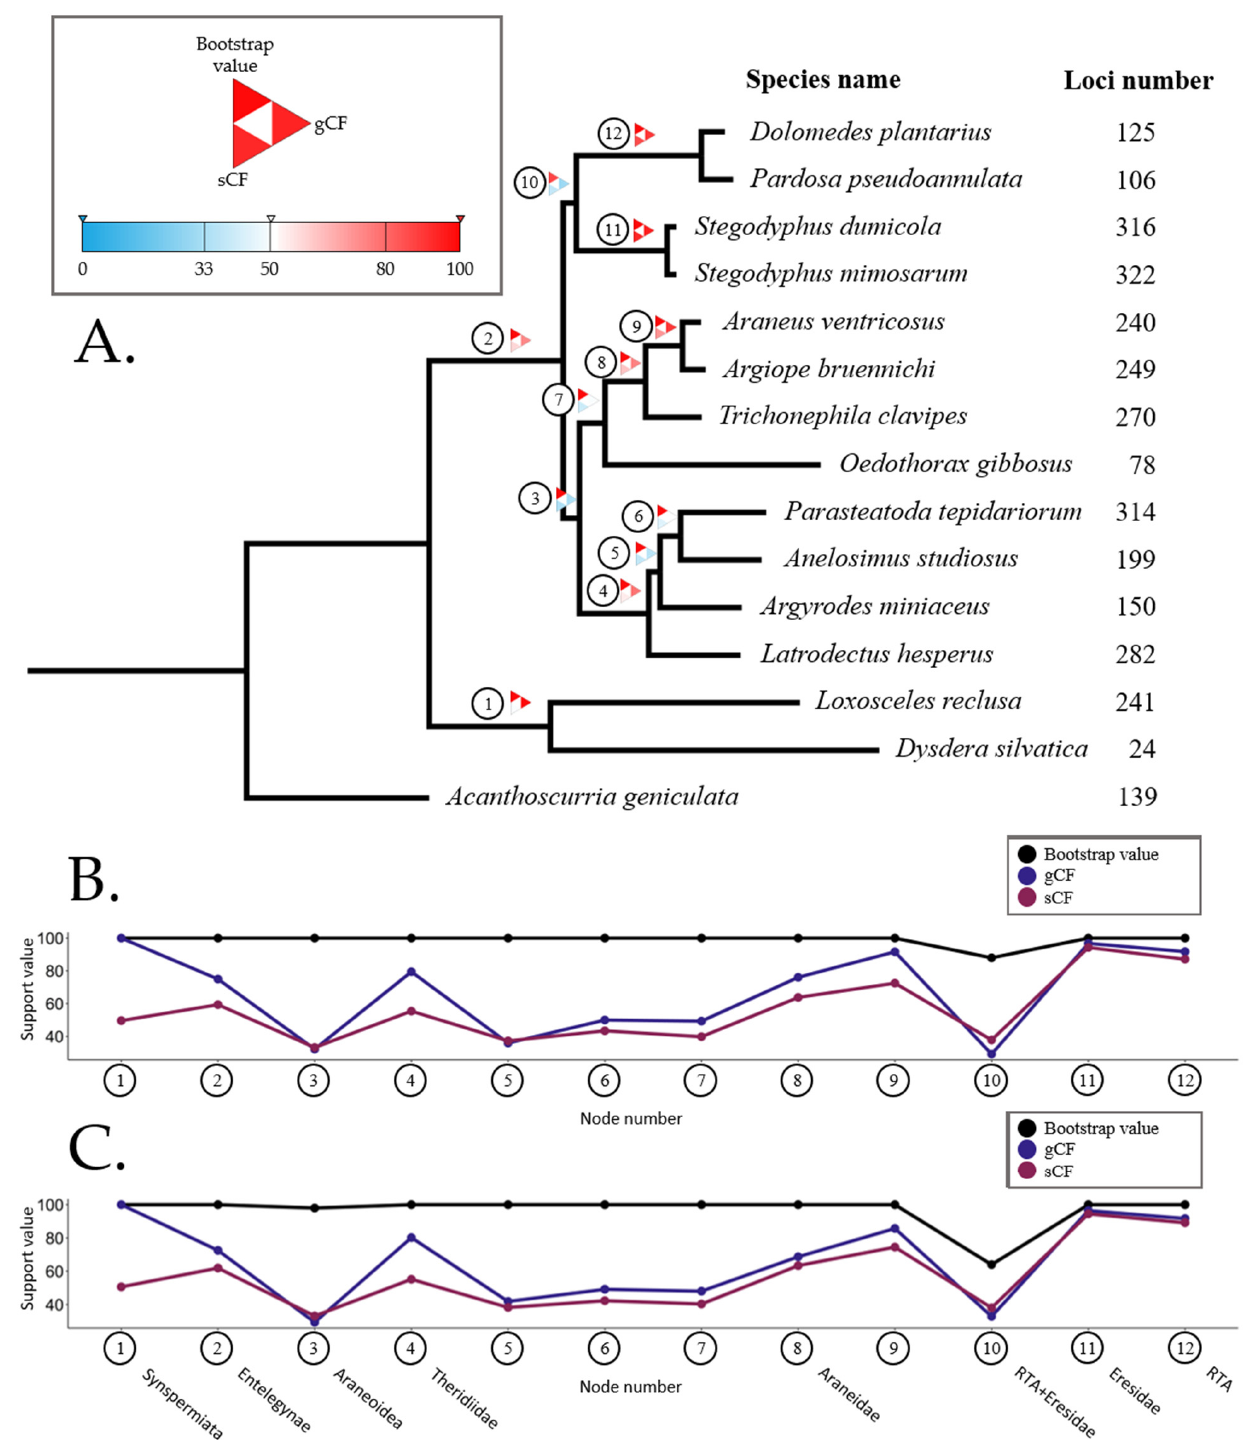
Figure 4. Phylogenetic tree of the data set that had the most captured loci (combined probe set filtered with 50% occupancy). ( A ) Tree topology: color of triangles represents three types of support values— bootstrap, gCF, and sCF—and dashed lines indicate the loci numbers used in tree reconstruction. ( B , C ) Support values for different nodes on reconstructed trees using combined probe set of 50% ( B ) and 75% ( C ) occupancies. Other trees, see Figures S1–S7.